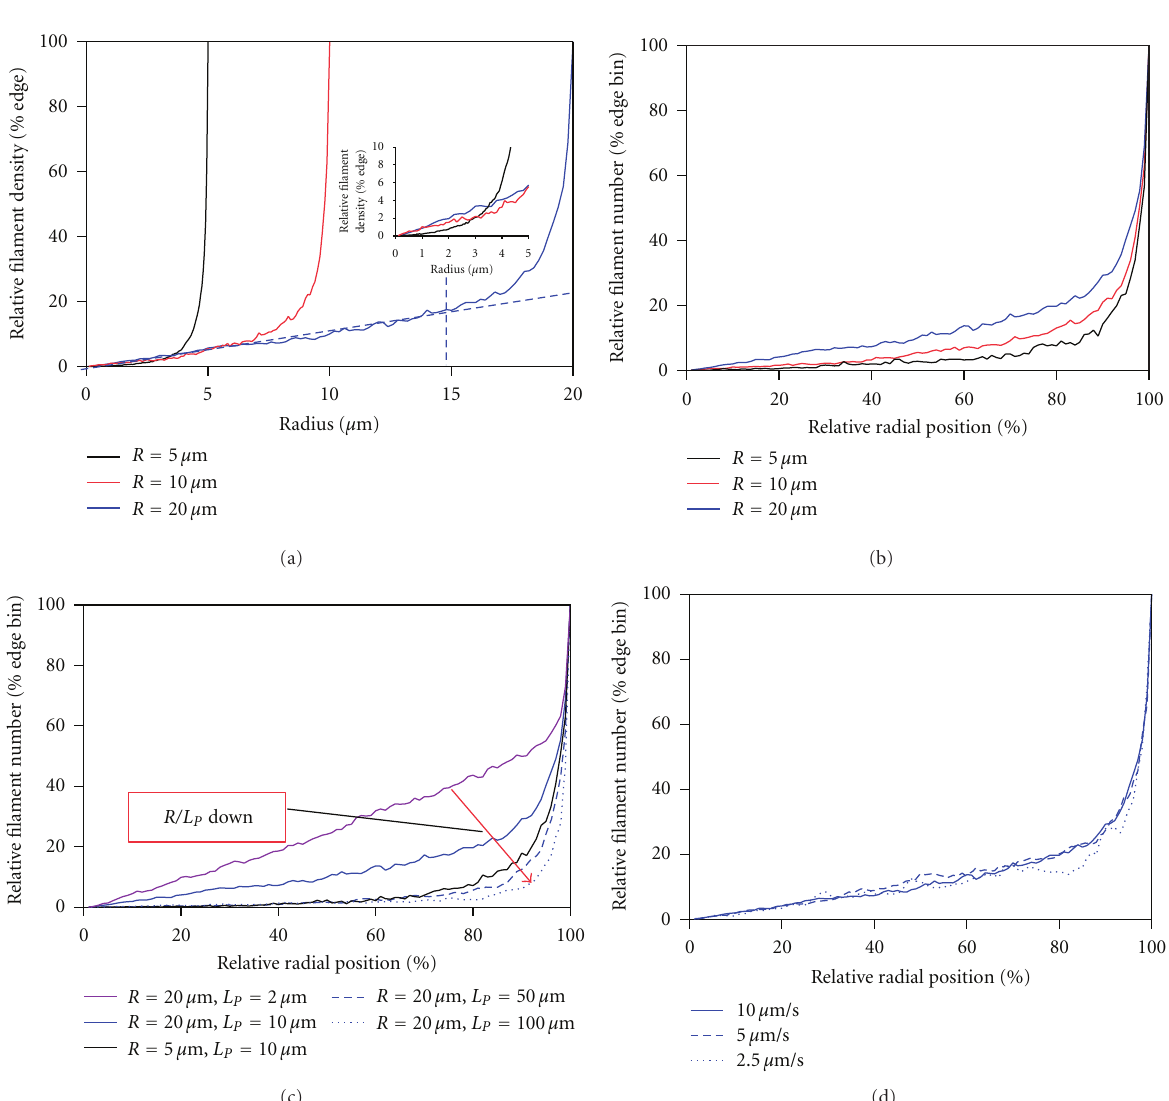
R = 20 μ m, L P = 10 μ m